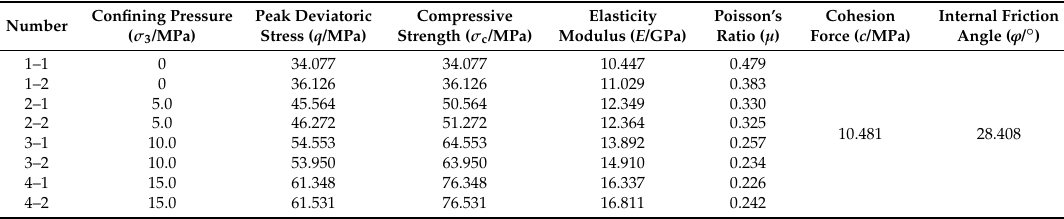
Table 1. Mechanical parameters obtained from the triaxial test. Number Confining Pressure ( σ 3